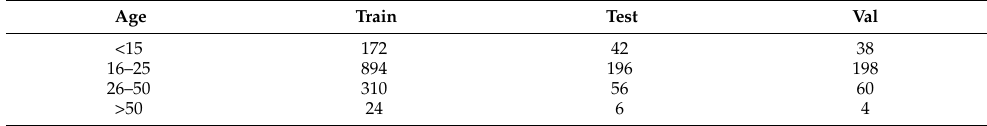
Table 5. The KHATT split (number of images) for age classification problem. The major class is the age group between 15 and 25, which constitutes 64.4% of the entire dataset.